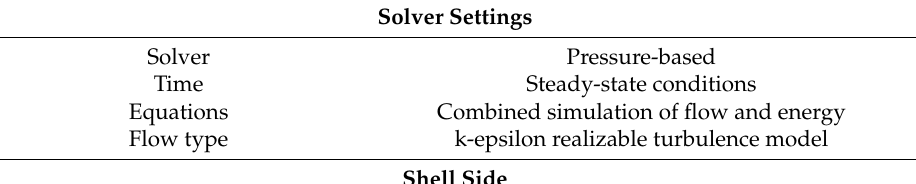
Table 3. Solver settings and boundary conditions used in the numerical